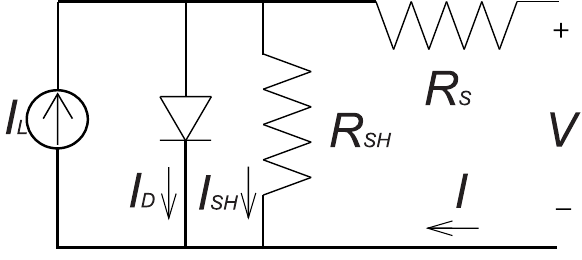
Figure 3. PV modeling equivalent